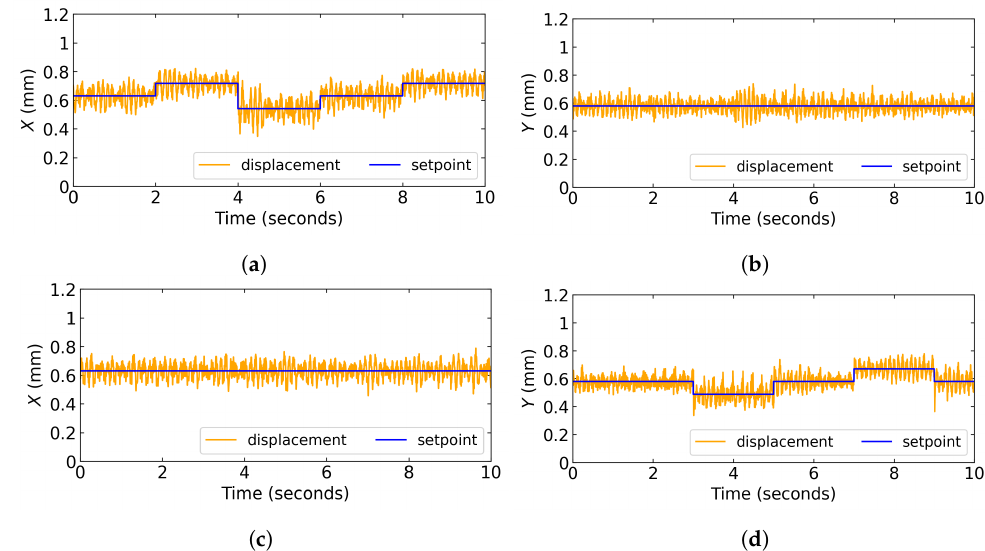
Figure 16. Response of radial position control under step setpoint changes for Nonlinear ADRC. ( a ) X -axis behavior with step setpoint changes applied. ( b ) Y -axis behavior with step setpoint changes applied to X -axis. ( c ) X -axis behavior with step setpoint changes applied to Y -axis. ( d ) Y -axis behavior with step setpoint changes applied.